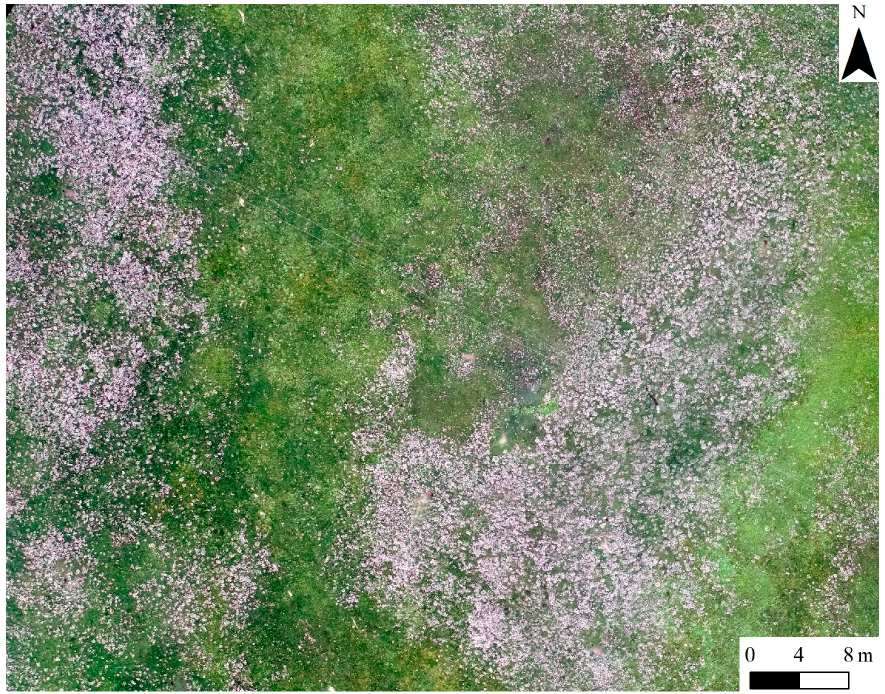
Figure 1. UAV RGB photo S . chamaejasme distribution in the study area. Clumped patches of a white-pink color are S . chamaejasm communities.